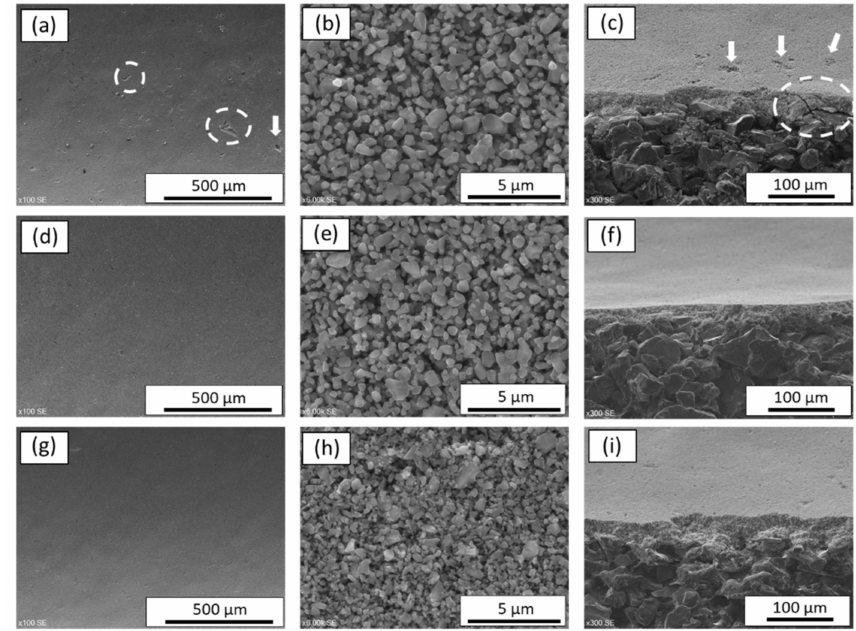
Figure 3. SEM images of surface and cross-section of the SiC membranes as a function of sintering temperature: ( a – c ) membranes at T max ; ( d – f ) membranes at T max -200 ◦ C; and ( g – i ) membranes at T max -300 ◦